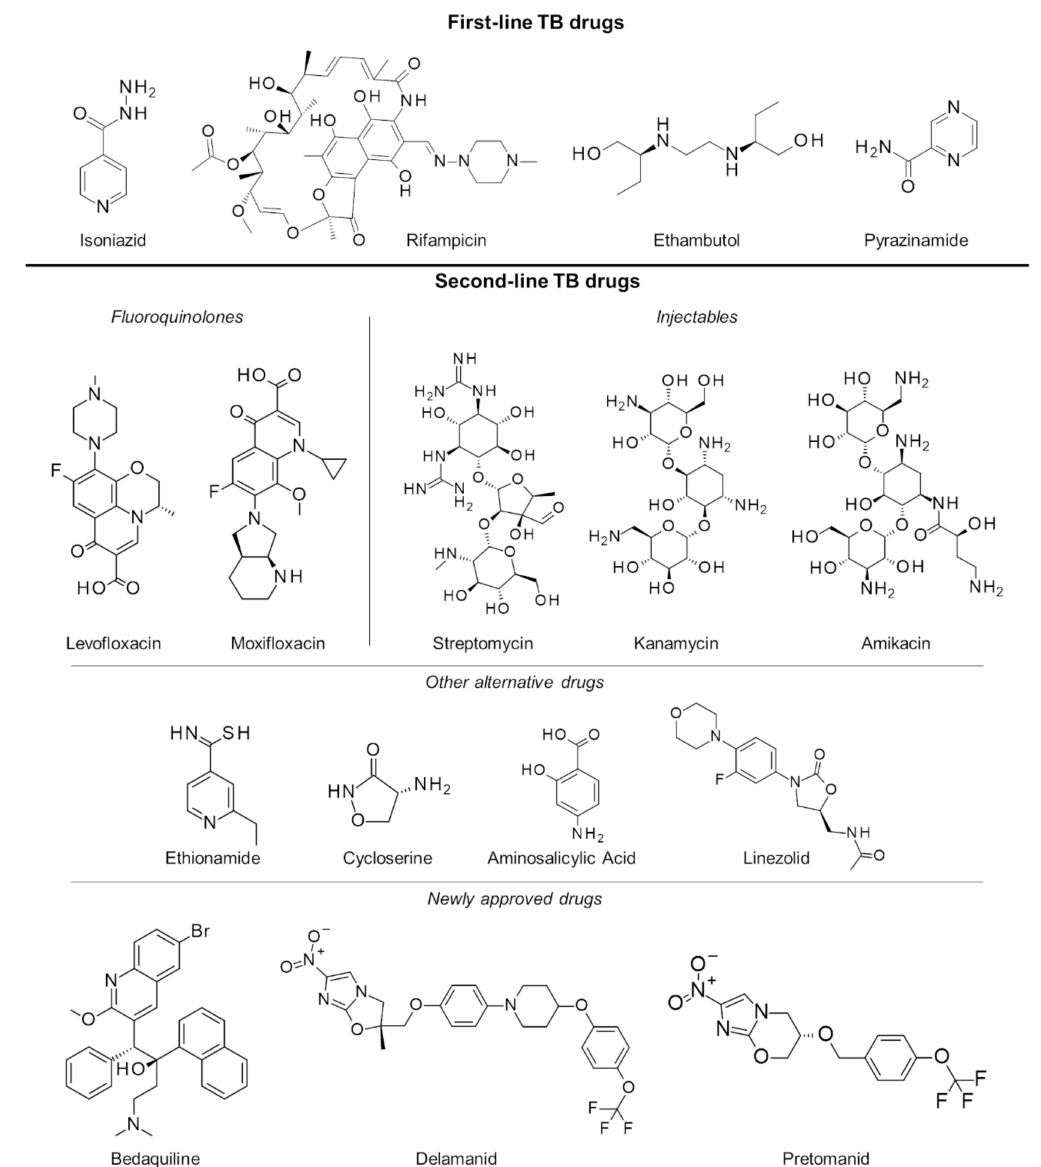
Figure 1. First- and second-line drugs approved for tuberculosis